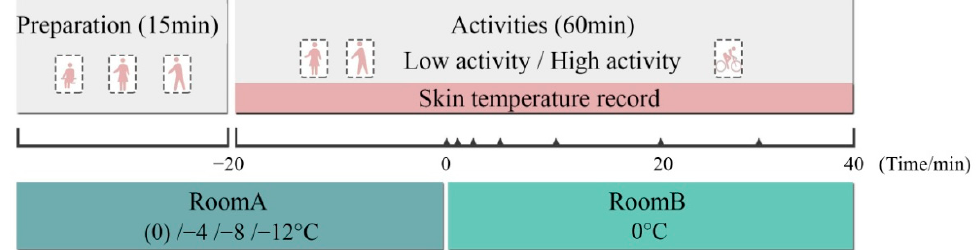
Figure 4. Experimental procedures. Survey points were set at the 0, 1st, 3rd, 5th, 10th, 20th, 30th and 40th min.